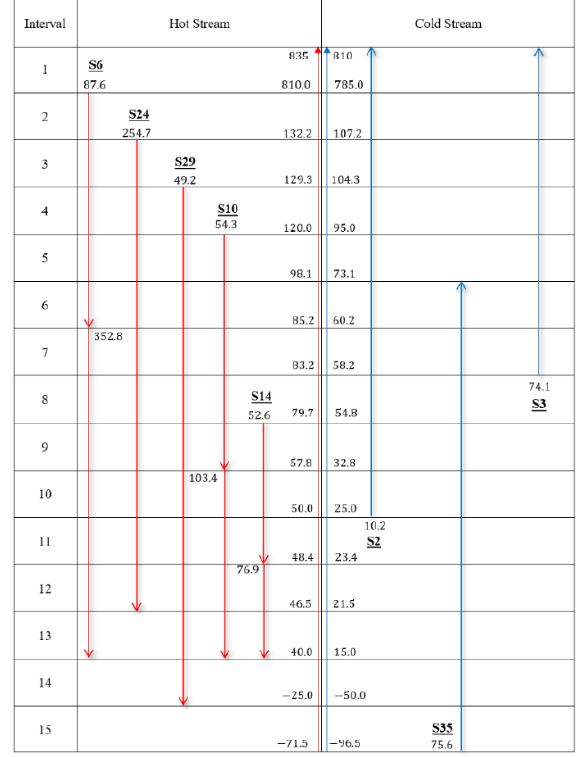
Figure 5. Temperature–interval diagram of the process.